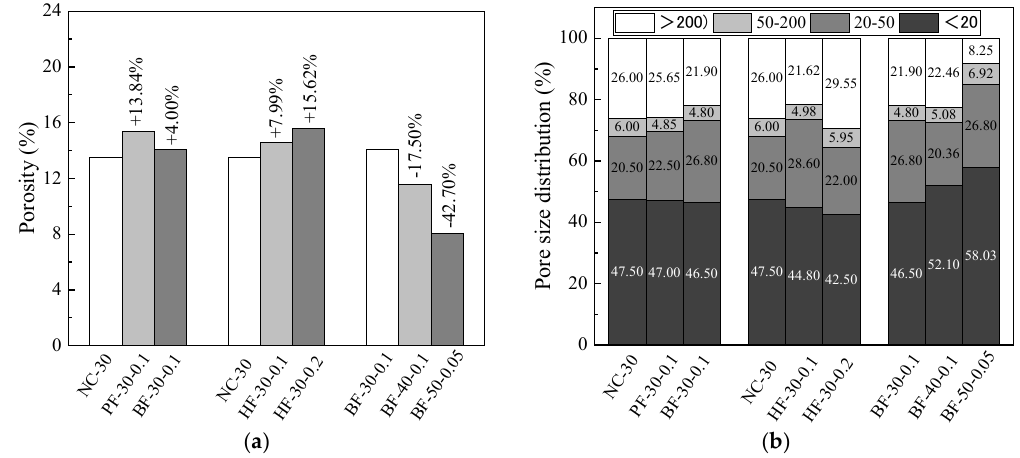
Figure 5. The pore structure of specimens: ( a ) total porosity; ( b ) pore size distribution.